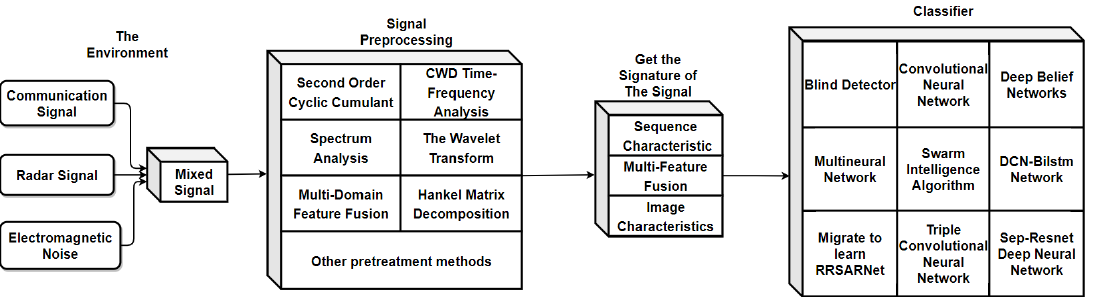
Figure 1. Roadmap of mainstream radiation source signal-sorting and identification technology under a low SNR.